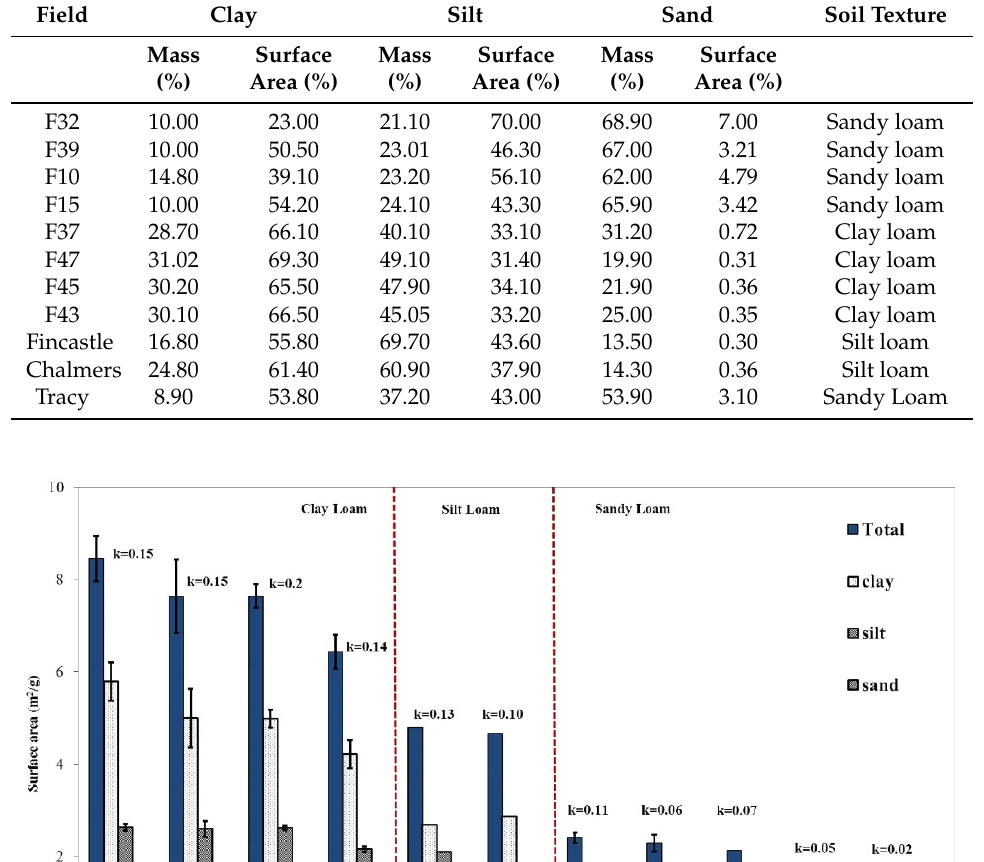
Table 2. Mass and mineral soil surface area percentage (clay, silt, and sand) and soil texture of selected soil samples.